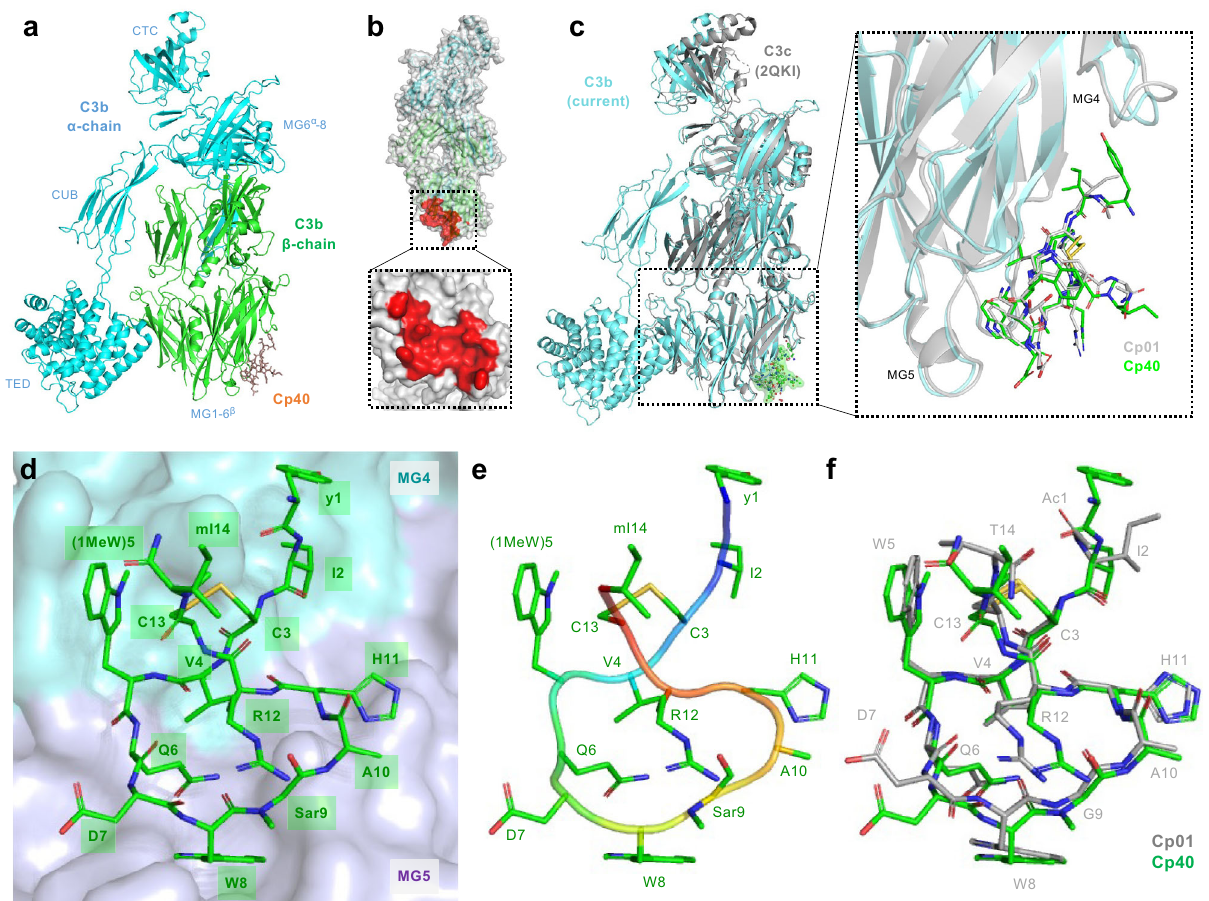
Fig. 2 | Crystal structure of Cp40-C3b complex and comparison with Cp01-C3c structure. a Cp40-C3b structure solved at 2.0-Å resolution showing a single molecule of Cp40 (stick representation) binding to the β -chain of C3b (green, cartoon representation; the α -chain is shown in cyan). b Cp40 binding site at the MG core of C3b highlighted in red. c Superimposition of the current Cp40-C3b structure(green/cyan)withthepreviousCp01-C3cstructure(grey).Thedottedbox shows an enlarged view of the compstatin binding region at the interface of the MG4 and MG5 domains of C3b/C3c. The two compstatin analogs are shown as sticks. d – f StructureofCp40initstarget-boundconformation. d Cp40isboundas